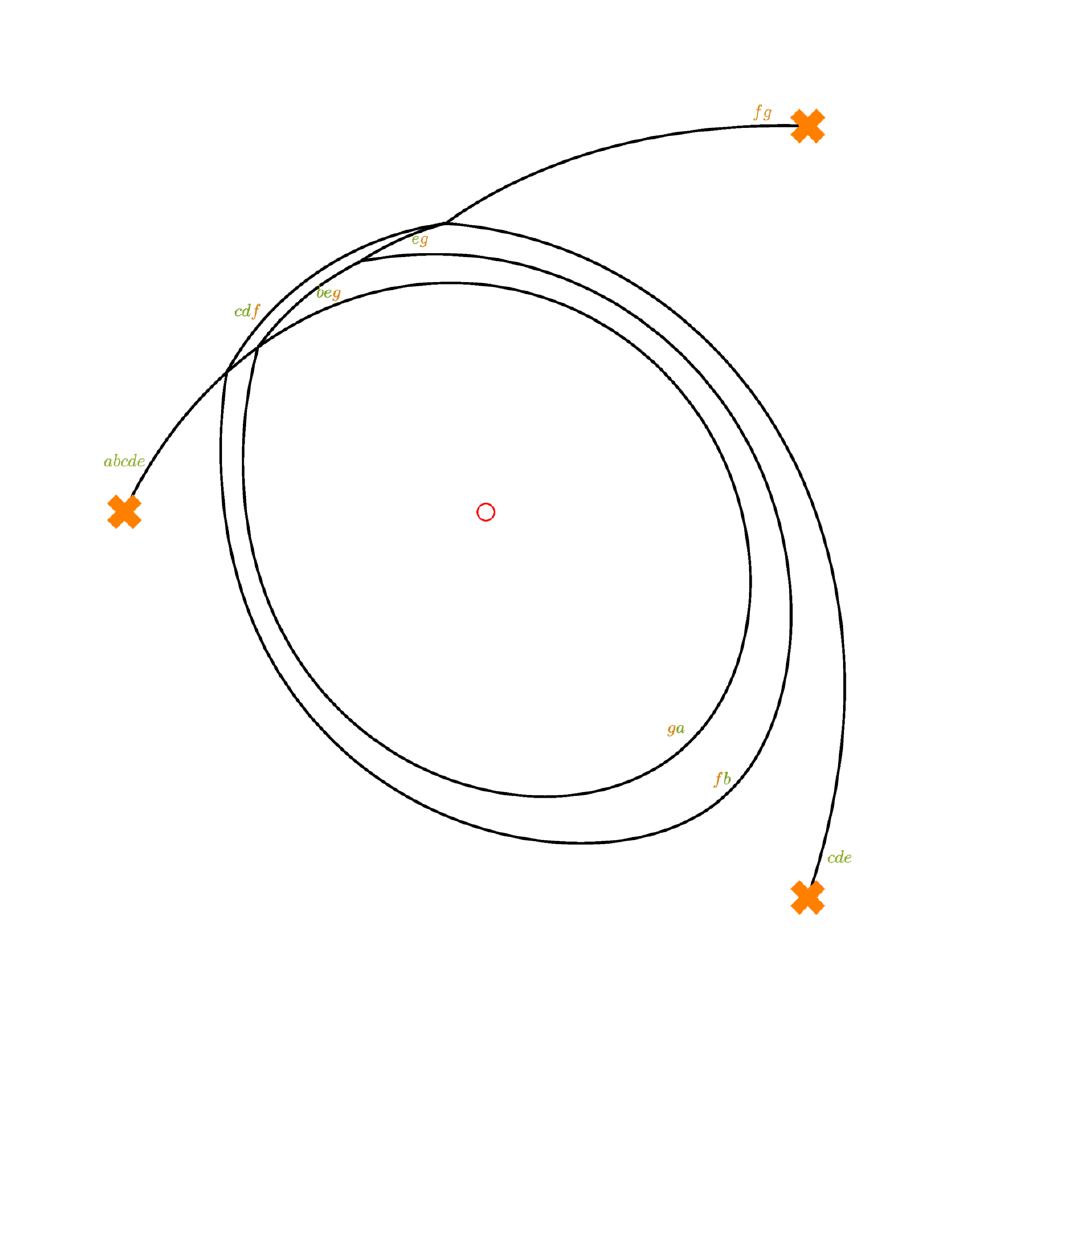
Figure 41. Tree module notation illustrated on the (cid:12)nite web for the (2,5) representation of the Kronecker-3 quiver.